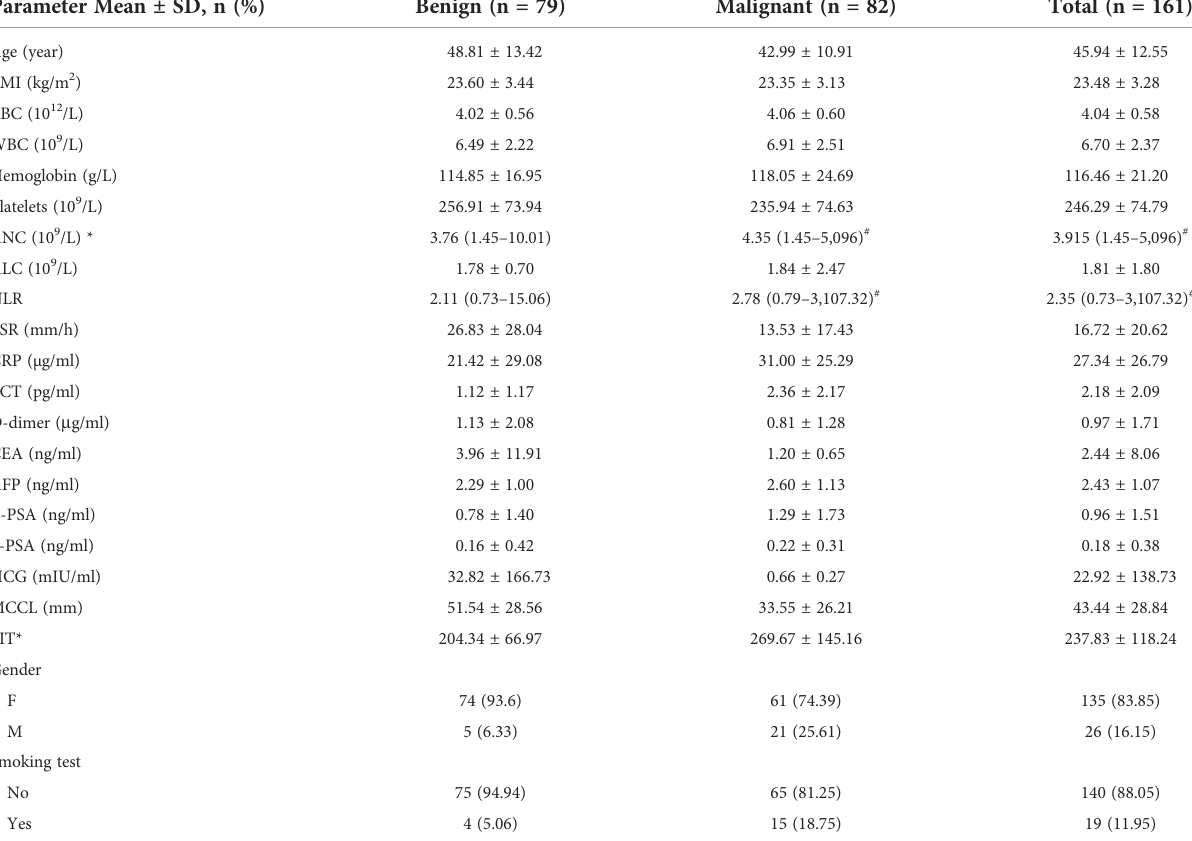
TABLE 1 Patient demographics, laboratory characteristics, and LIT